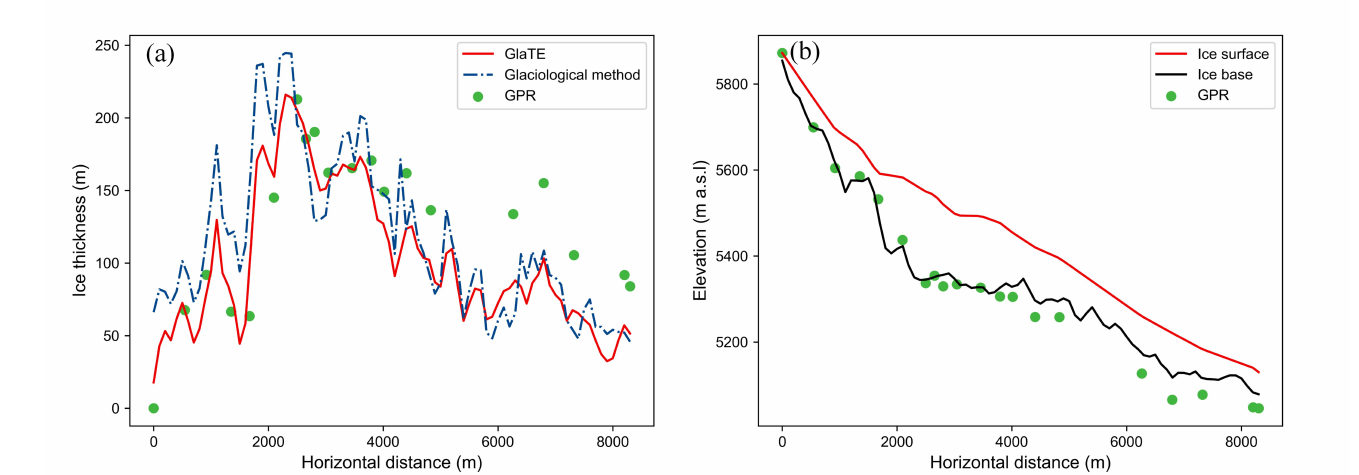
Figure 2. Geometry of JMYZG. ( a ) Ice thickness obtained by three different methods (the red solid line represents the GlaTE inversion results; the blue dash-dotted line represents the ice thickness obtained by glaciological method (Clarke et al., 2013 [38]); the green points represent the GPR data. ( b ) The geometry of JMYZG along the flowline (The red and b solid lines represent the ice surface and the modeled ice base, respectively. The green points are the ice base measured by GPR).